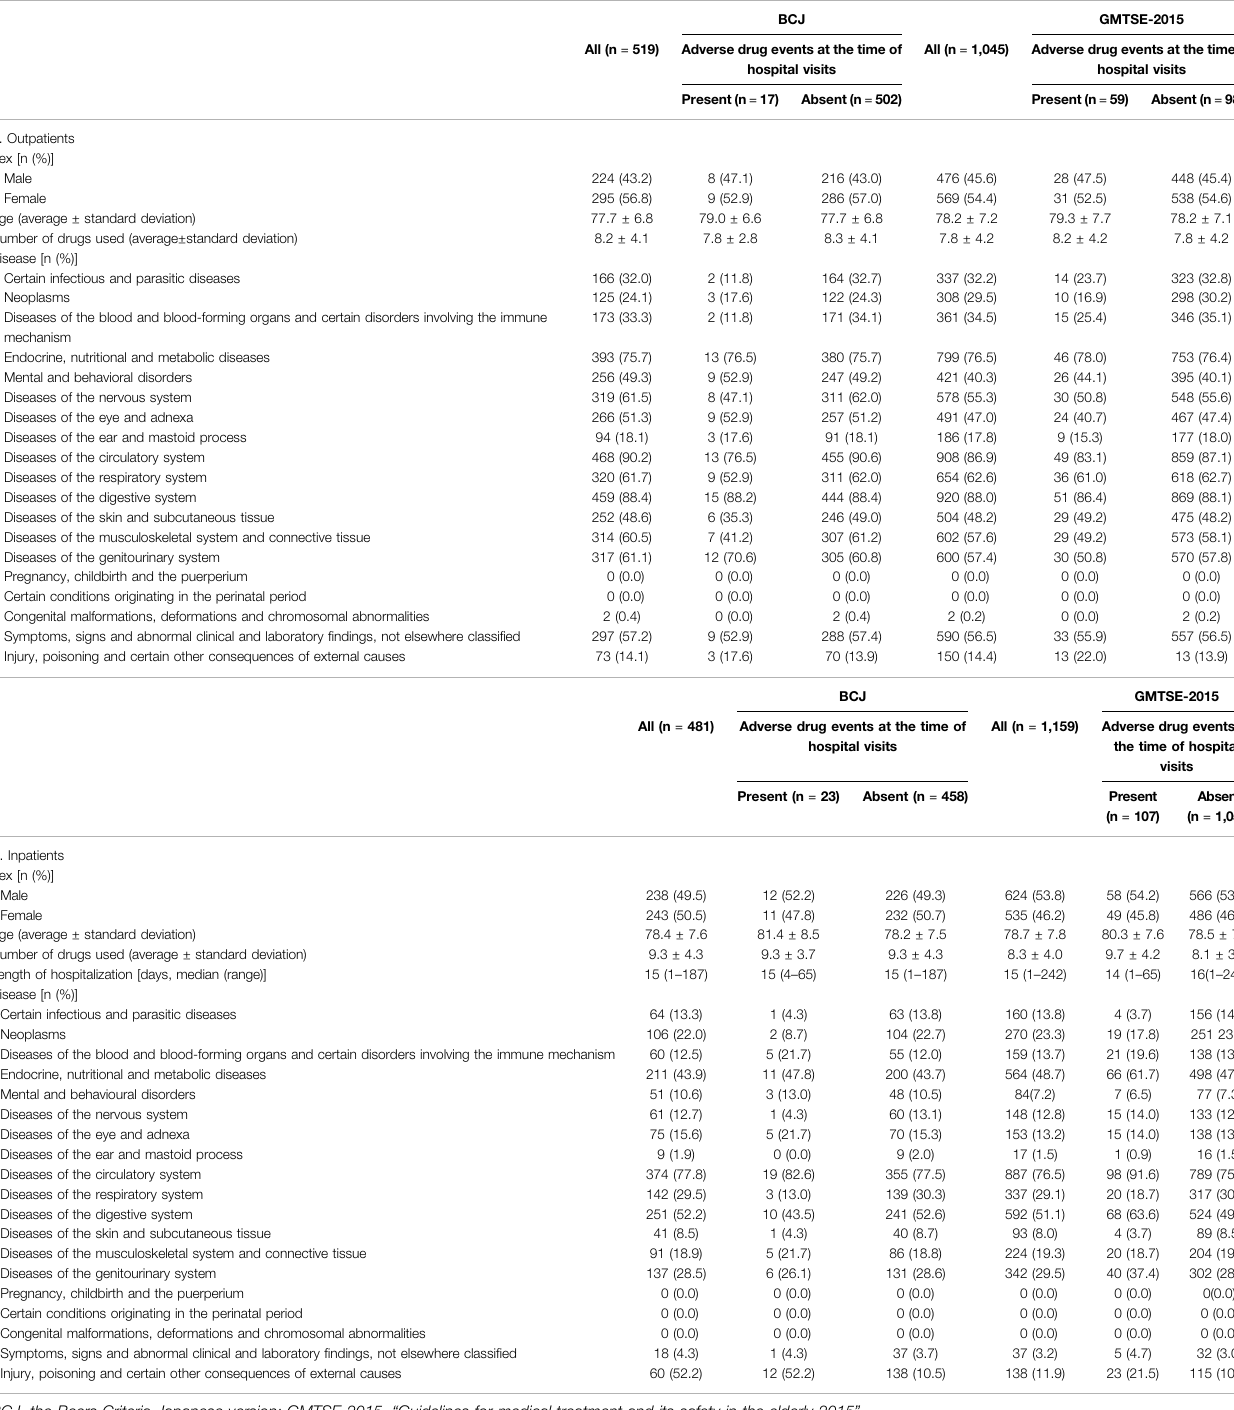
TABLE 6 | Background of patients with the drugs listed in the Beers Criteria Japanese version and “ Guidelines for medical treatment and its safety in the elderly 2015 ”